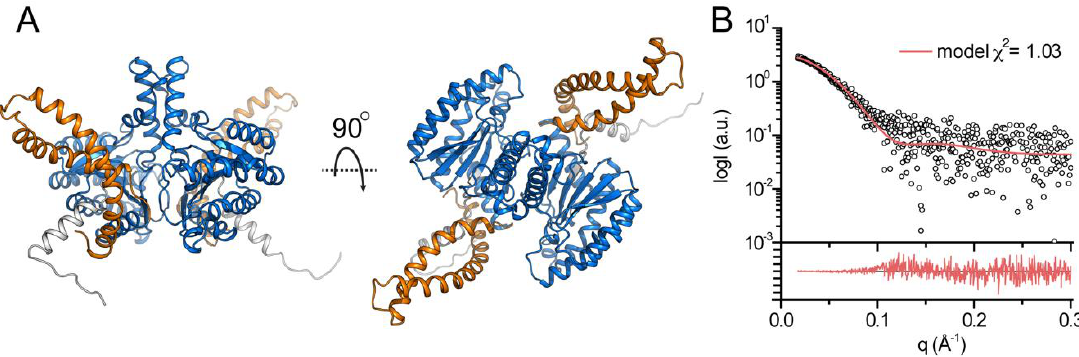
Figure 5. Computational modeling of full-length human DHDDS. ( A ) The model of full-length human DHDDS is shown in cartoon representation. The N-terminus, the cis -prenyltransferase homology domain, and the C-terminal helix–turn–helix motif are colored gray, blue, and orange, respectively. ( B ) Fit of the theoretical SAXS curve of the model (red line) to the measured SAXS profile (circles). The lower panel shows the residuals